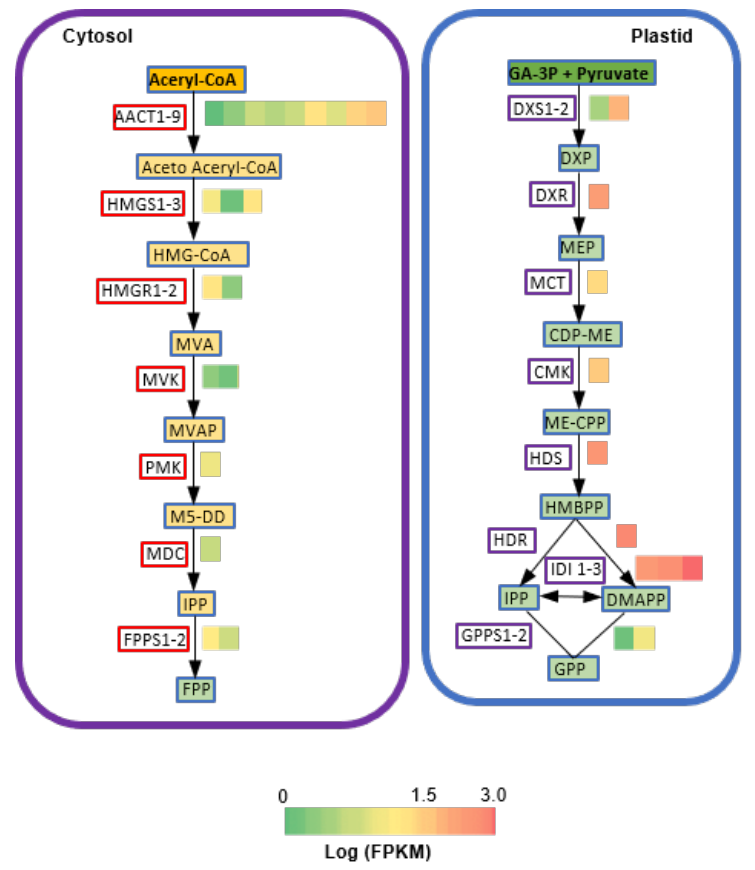
Figure 3. Representative terpenoid biosynthesis pathways with cognate heat maps for transcript levels of genes from C. florida ‘Kaiser’ transcriptome data with substrates and products. Green/red color-coded heat maps represent relative transcript level calculated with fragments per kilobase of transcripts per million mapped fragments (FPKM). Abbreviations of enzymes: AACT , acetyl-CoA C- acetyltransferase; HMGS , hydroxylmethylglutaryl-CoA synthase; HMGR , hydroxymethylglutaryl-CoA reductase (NADPH); MVK , mevalonate kinase; PMK , 5-phospho-mevalonate kinase, MDC , mevalonate diphosphate decarboxylase; FPPS , farnesyl pyrophos-phate synthase; DXS , 1-deoxy- D - xylulose-5-phosphate synthase; DXR , 1-deoxy-D-xylulose-5-phos-phate reductoisomerase; MCT , 2- C-methyl- D -erythritol 4-phosphate cytidylyltransferase; CMK , 4-diphosphocytidyl-2-C-methyl-d- erythritol kinase; HDS , ( E )-4-hydroxy-3-methylbut-2- enyl diphosphate synthase; HDR , 4-hydroxy-3- methylbut-2-enyl diphosphate reductase; IDI , isopentenyl-diphosphate delta-isomerase; GPPS , geranyl diphosphate synthase. Compound abbreviations: HMG-CoA, 3-hydroxy-3-methylglutaryl-CoA; MVA, mevalonate; MVAP, 5-phosphomevalonate; M5-DD, 5-pyrophosphomevalonate; FPP,